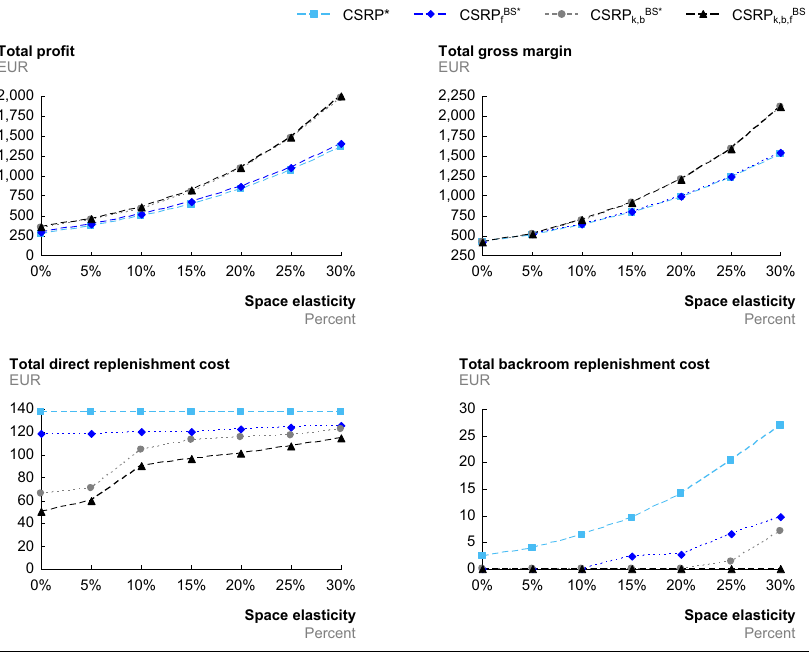
Fig. 4 Total profits, total gross margins and total replenishment cost for each modeling